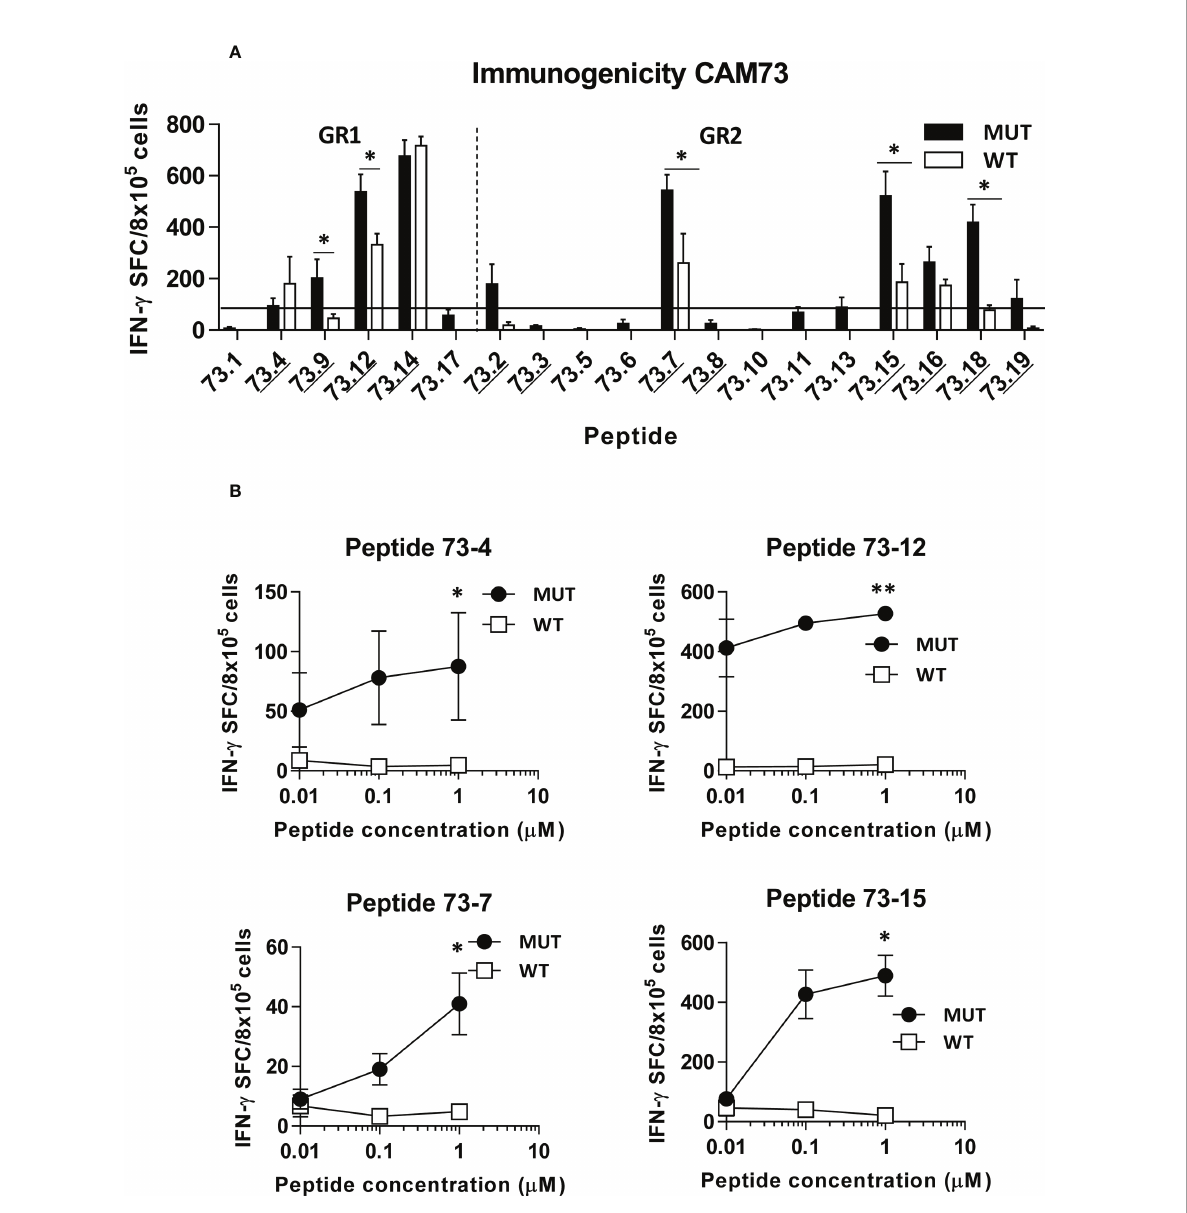
FIGURE 3 In vivo immunogenicity of predicted peptide epitopes from patient CAM73. HHD-DR1 mice (n=4/group) were immunized with peptide pools (4- 5 peptides/pool; 100 nanomoles of each peptide/pool) plus poly(I:C) and antiCD40 adjuvants at days 0 and 7. One week after the boost they were sacri fi ced and splenocytes were stimulated with individual peptides (either mutated or WT version at 10 m M) (A) and response evaluated by using an IFN-gamma ELISPOT assay. Responses were considered positive when SFC > 50. Results correspond to the sum of 2-3 independent experiments. Peptides experimentally proven as binders are underlined. (B) Lymphocytes showing positive recognition of the WT version were titrated with lower peptide concentrations. (*P<0.05; **P<0.01; MUT vs WT